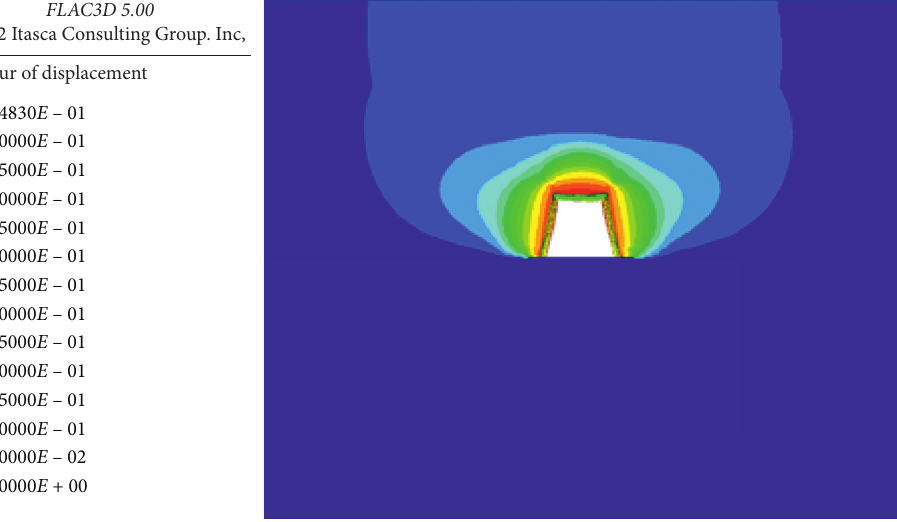
Figure 14: Cloud map of the roadway surrounding rock displacement under the original support scheme.